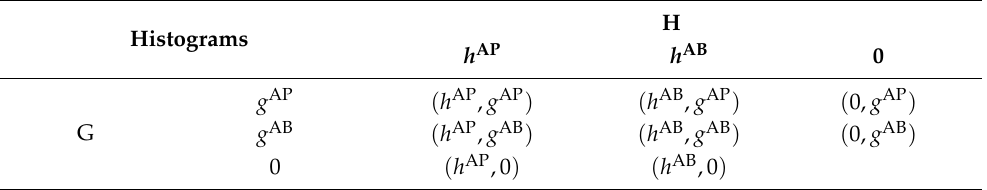
Table 1. Combinations of apparent (AP) and absent (AB) colors.